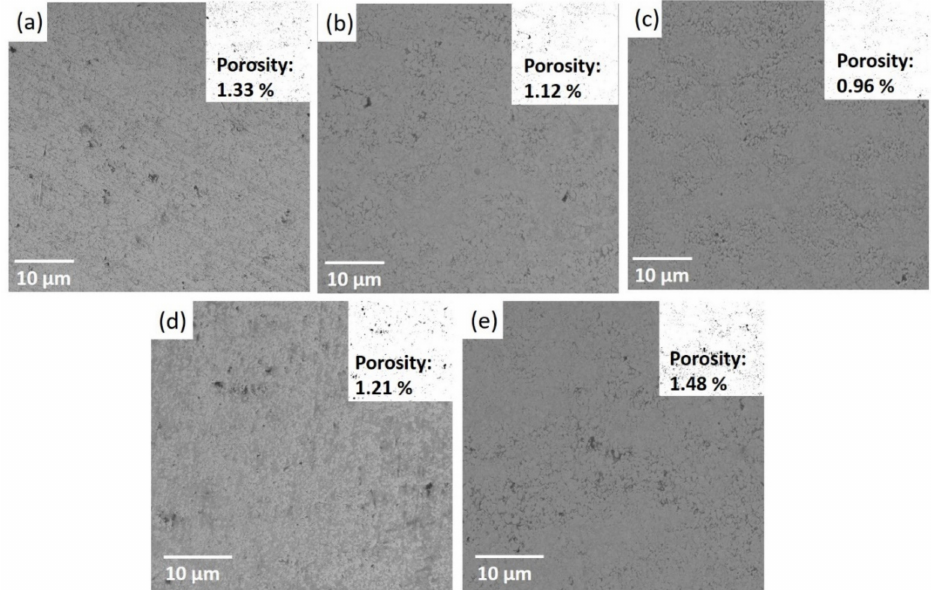
Figure 5. Porosity analysis of ( a ) as-sprayed, ( b ) HT 650, ( c ) HT 800, ( d ) HT 950, and ( e ) HT 1100 coatings. The microhardness of as-sprayed, HT 650, HT 800, HT 950, and HT 1100 coatings are 1172, 1211, 1286, 1312, and 1057 HV, respectively, as shown in Figure 6 (the standard deviation is adopted as the error bar).